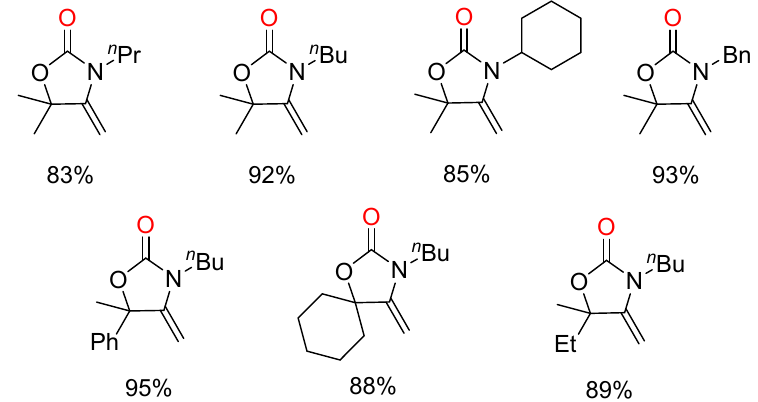
Figure 1. Some 2-oxazolidinone derivatives by Ag 2 WO 4 /Ph 3 P system (isolated yields are given) [21].